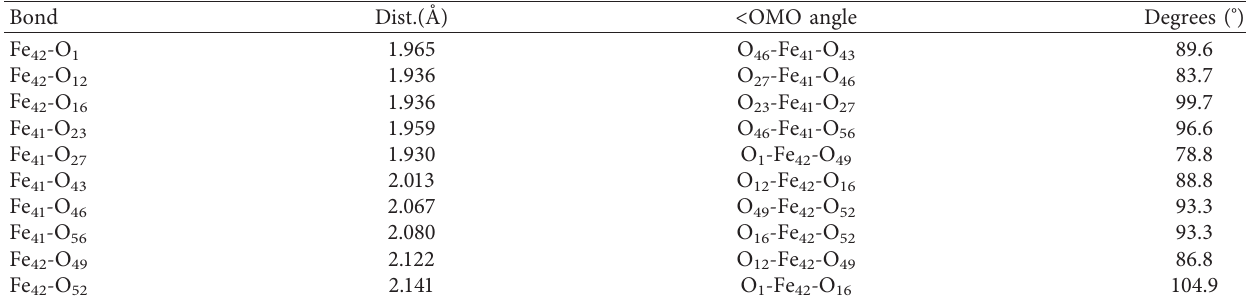
Table 5: The bond parameters of BOEN bonded with two Fe 2+ ions.